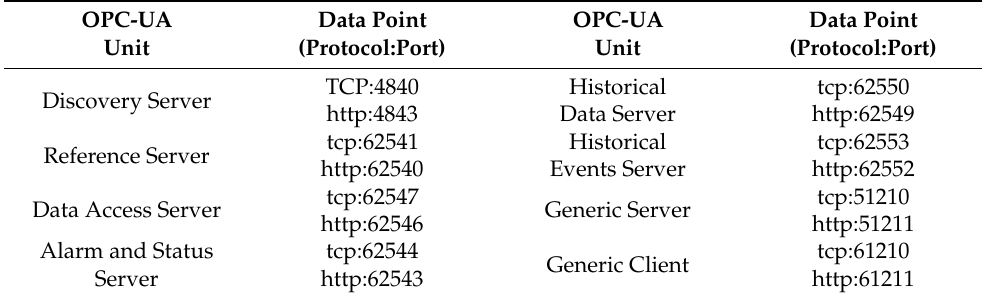
Table 1. Communication interfaces for the OPC UA